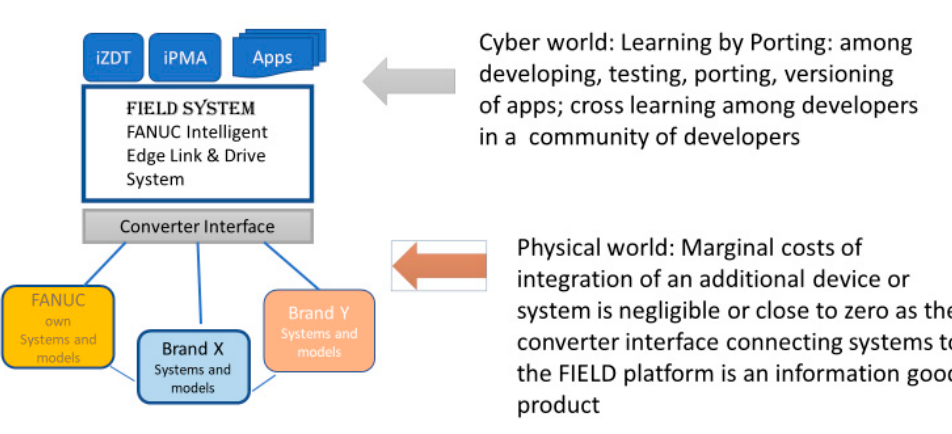
Figure 5. Illustrating the essential economies of an OPEN two-sided digital platform.